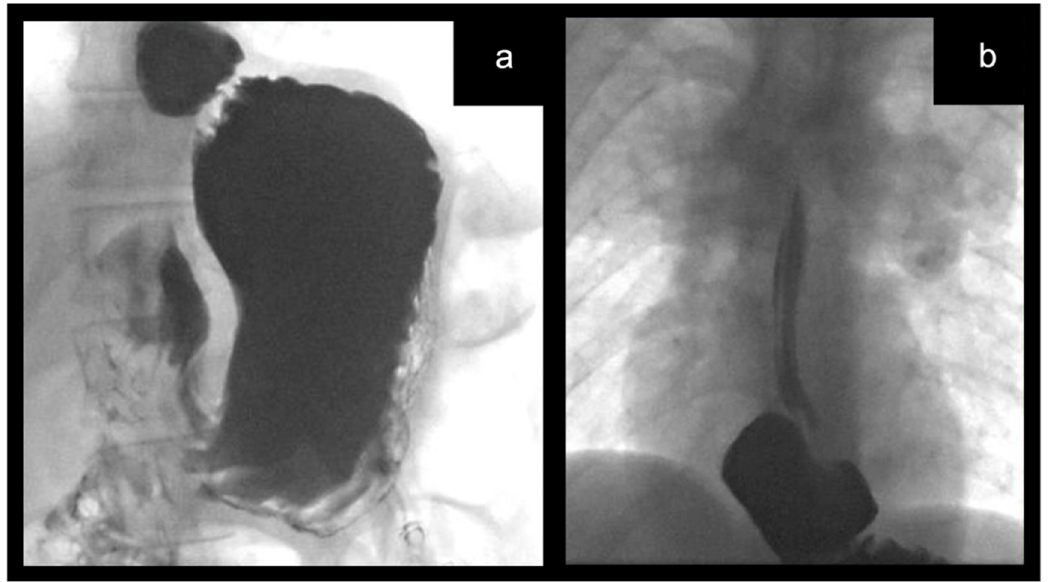
Figure 1. ( a , b ) Upper gastrointestinal contrast study showing failed fundoplication and moderate hiatal hernia with reflux to the upper esophageal level.